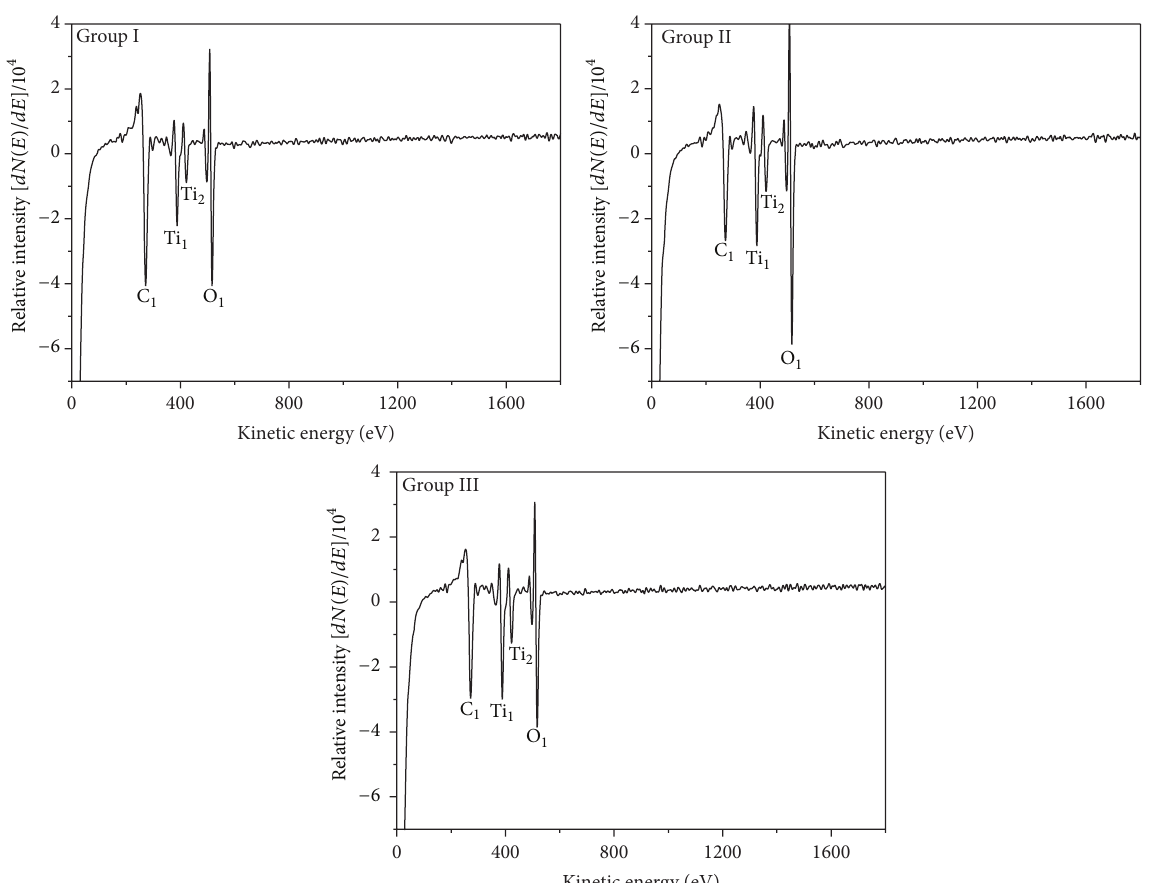
Figure 3: AES spectroscopy to determine the relative concentrations of elements on the sample